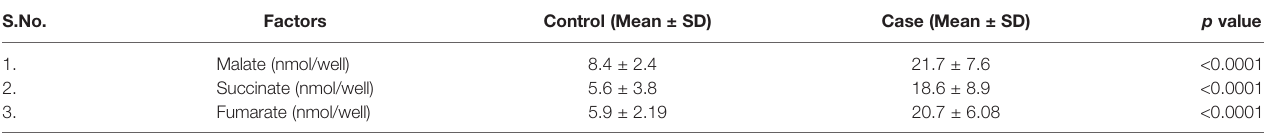
TABLE 3 | All the quantitative details of Krebs cycle oncometabolite. S.No.